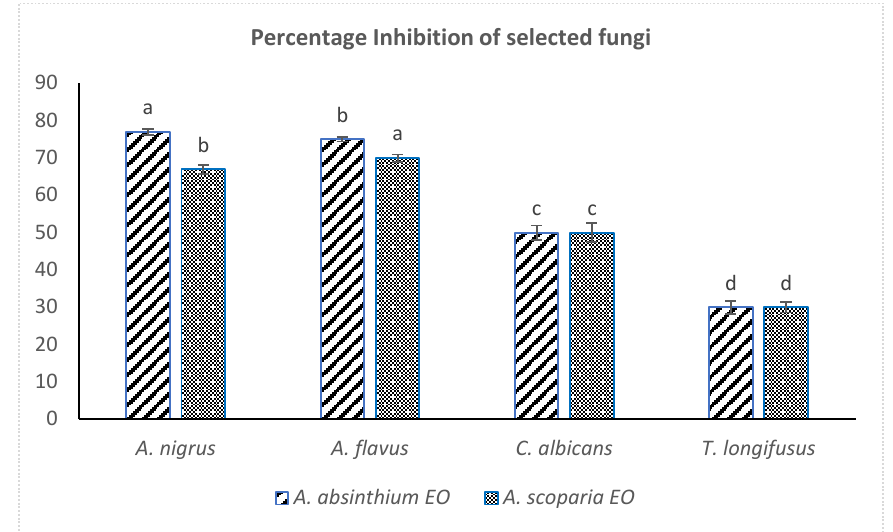
Figure 3. Comparative antifungal effects (% inhibition) of EOAS and EOAA (dose of 500 µg/mL DMSO). One same letter shows no significant difference.